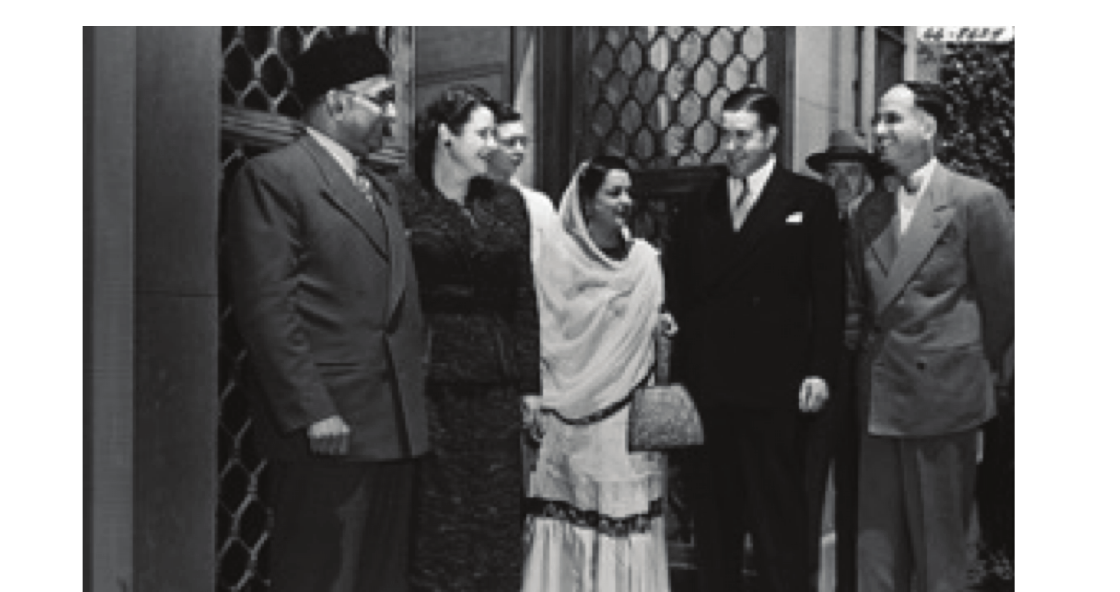
Figure 1: Pakistan First Lady Begum Rana Liaquat Ali Khan wearing traditional clothes